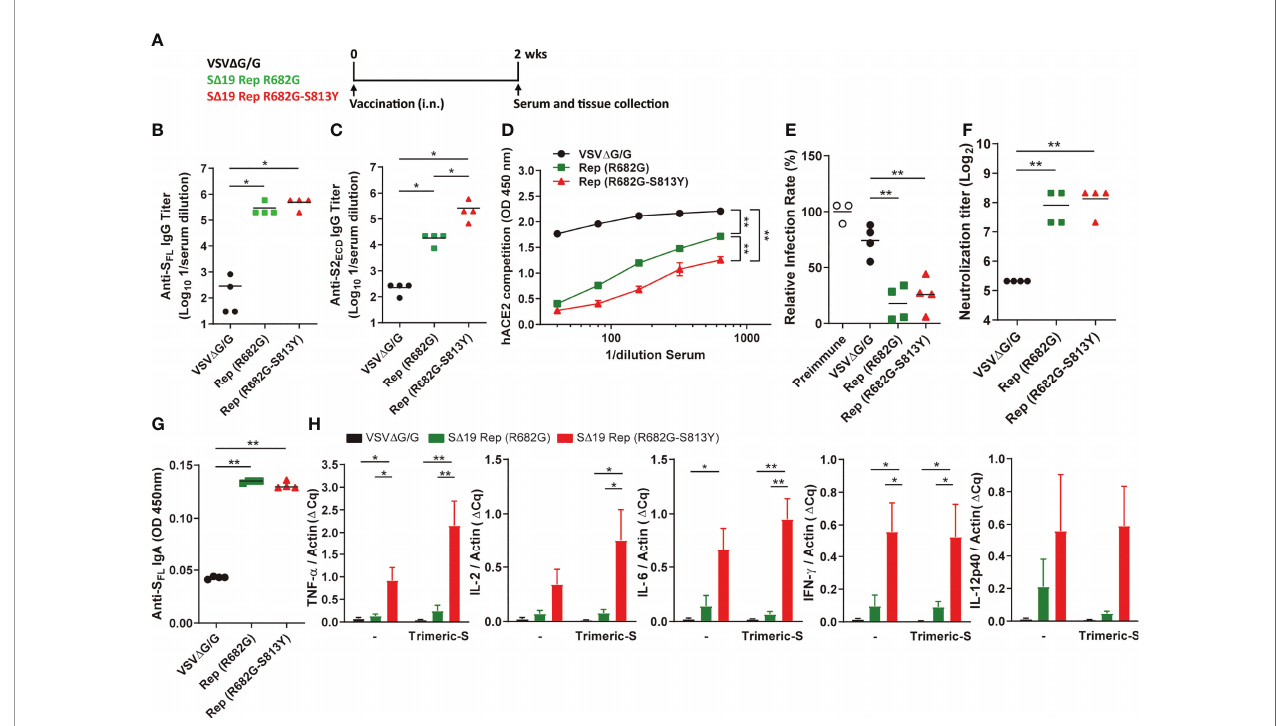
FIGURE 7 | The S D 19 Rep (R682G-S813Y) mutant stimulates robust neutralizing antibodies and Th1 immune response in hamsters. (A) Experimental design of a single dose vaccination with VSV D G/G (control virus), S D 19 Rep-R682G and S D 19 Rep-R682G-S813Y in hamster (i.n.; 1×10 6 pfu or ffu/hamster; n=4). The serum, spleen, and lung of the vaccinated hamsters were collected 2 weeks post-vaccination. Serum samples were subjected to anti-S FL (B) and anti-S2 ECD (C) IgG ELISA, the RBD-hACE2 interaction competition assay (D) , and the neutralization assay with the VSV D G-based S pseudotyped virus (E) and SARS-CoV-2 virus (F) . The anti- S FL IgA expression in the lung homogenates was measured by ELISA (G) . The isolated hamster splenocytes were stimulated with or without trimeric-S protein (5 m g/ ml) for 72 hrs, and subjected to detect the TNF- a , IL-2, IL-6, IFN- g and IL-12 mRNA expression by qRT-PCR (H) . *P < 0.05; **P <